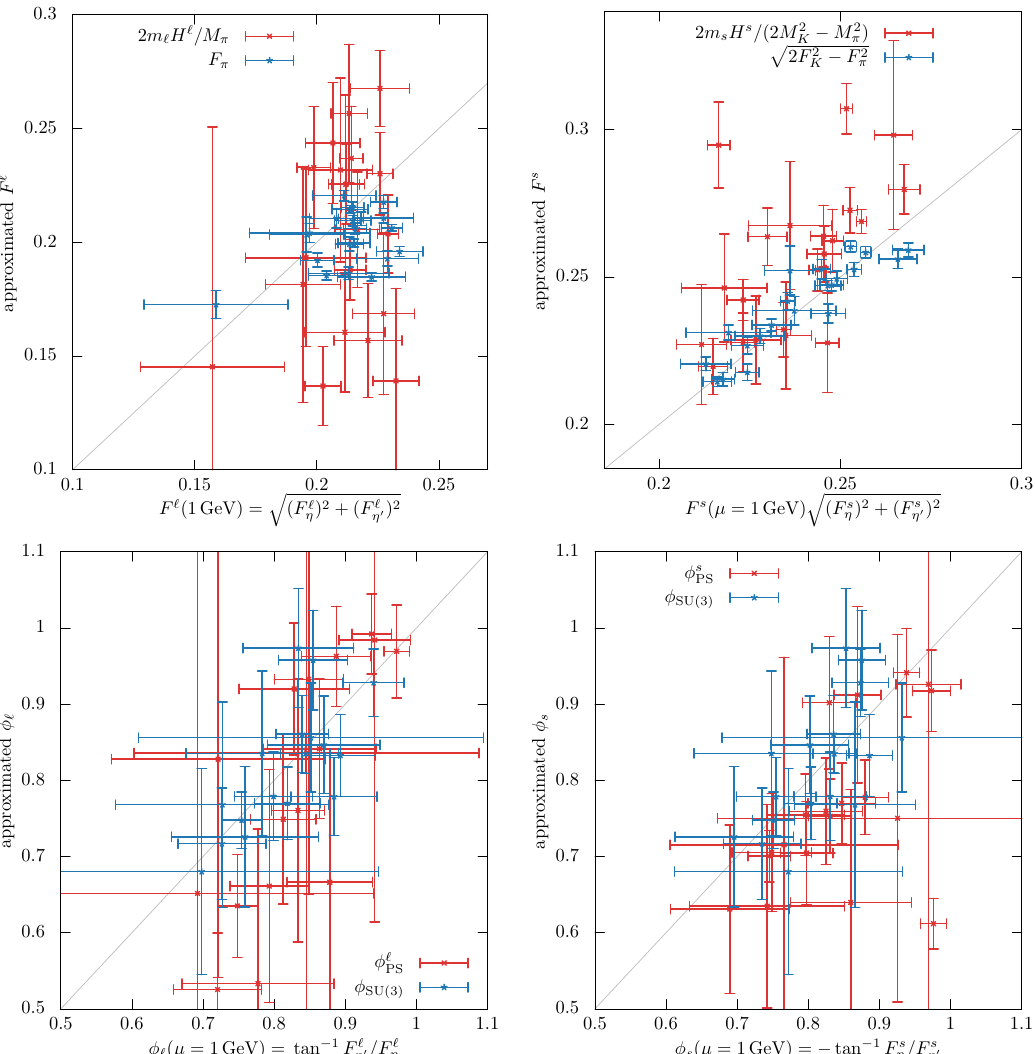
Figure 15. Light and strange decay constants (top) and angles (bottom) determined on each ensemble at the QCD scale µ = 1 GeV . The central values and errors in the x -direction indicate the results obtained directly from the axialvector matrix elements, while the position and error in the y -direction indicates the values constructed from the pseudoscalar matrix elements (red, eqs. (7.19) and (7.21)). For the decay constants, the expectations derived from combinations of the pion and kaon masses and decay constants (blue, eq. (7.17)) are also displayed, while for the angles φ SU(3) (eq. (7.20)) is also shown. The blue points have been shifted slightly to the right for better